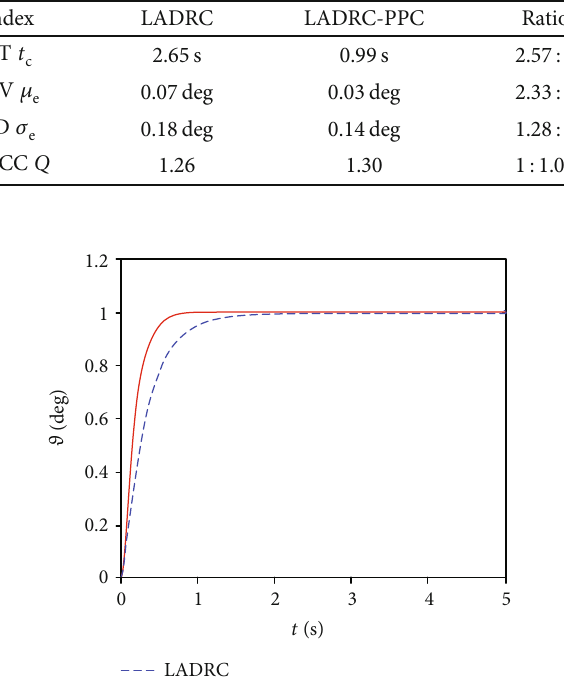
Figure 3: Pitch angle.